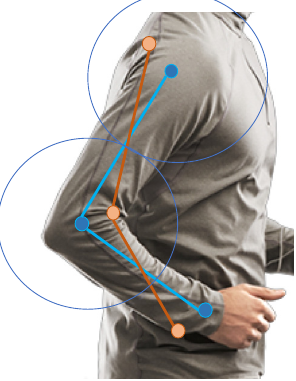
Figure 6. The concept of the percentage of correct parts (PCP). The MSE and PCP were measured using 10 cross-validations. For each cross-validation, the indoor dataset was randomly partitioned into training (80%) and test sets (20%) for the fixed activity ratios.